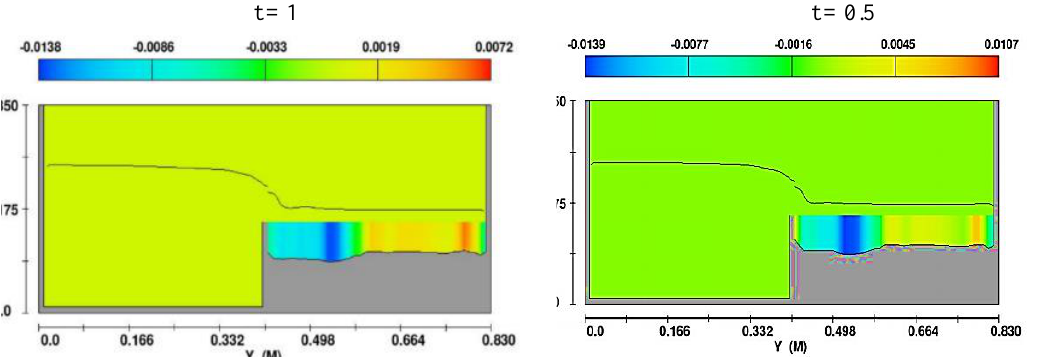
Figure 5. Cross section of the channel at the upstream of side weir(x = 1.8